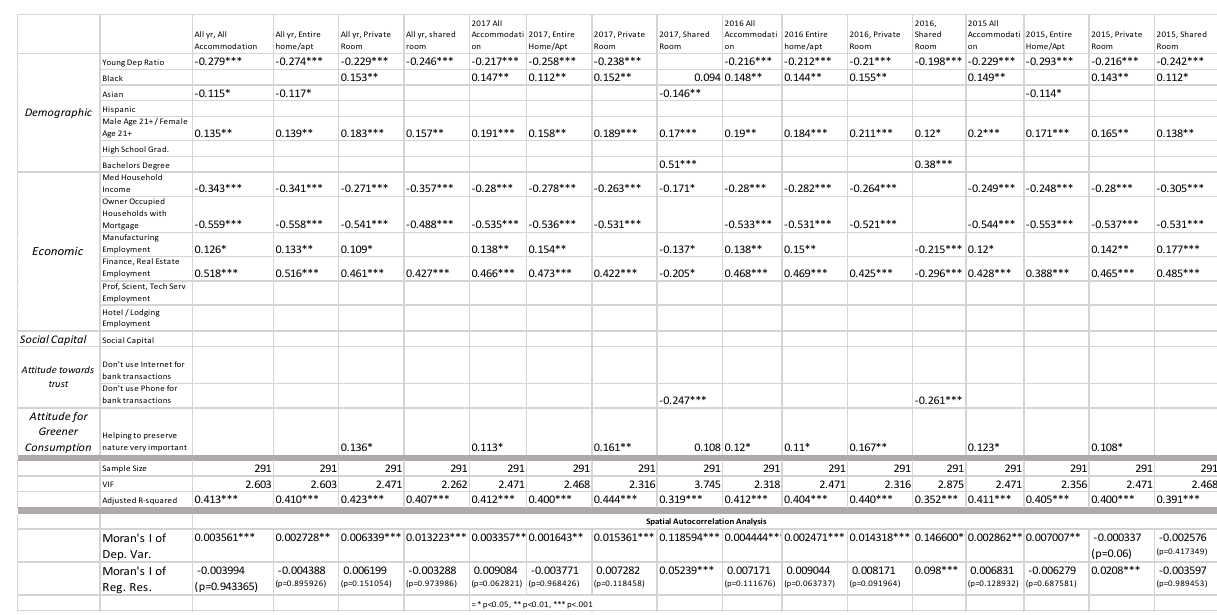
Table 3. Regression Results, Greater Los Angeles, 2015-17, for various types of Airbnb